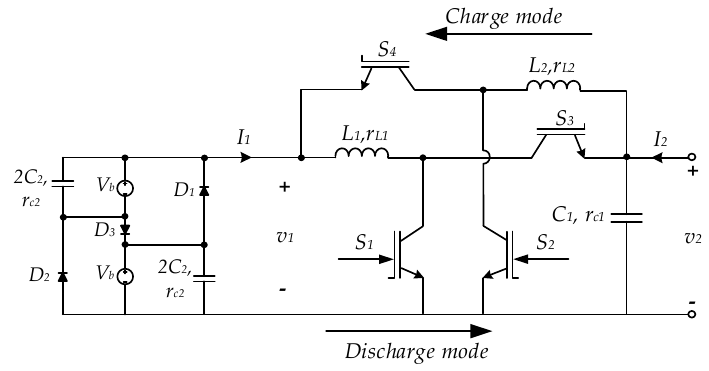
Figure 2. Proposed bidirectional DC-DC converter.